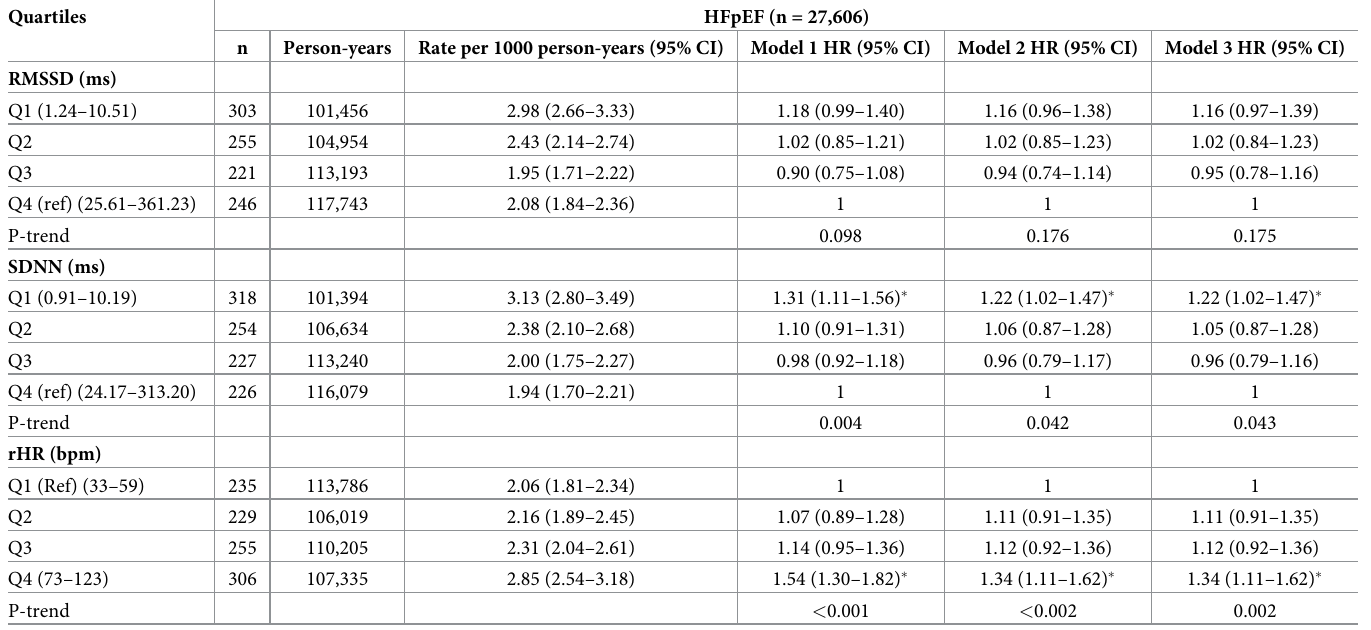
Table 3. Cox proportional hazard ratio with 95% CI of incident hospitalized HFpEF events by quartiles of baseline RMSSD, SDNN and rHR. Quartiles